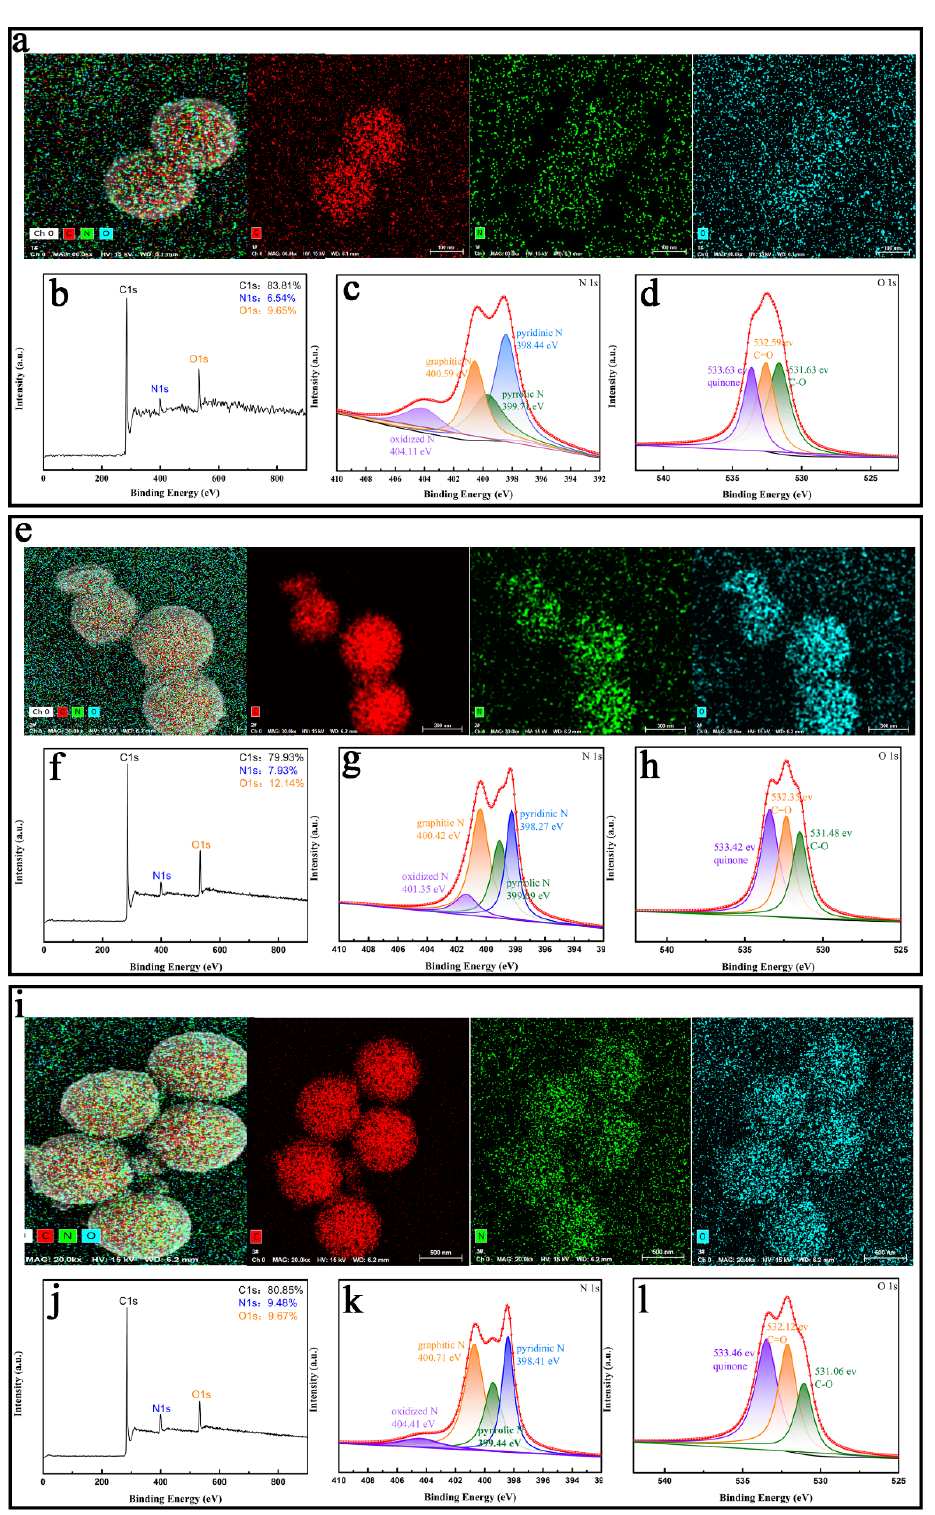
Figure 7. The ( a ) EDS element mapping analysis, ( b ) XPS survey spectrum, ( c ) high-resolution XPS spectra of N 1 s and ( d ) high-resolution XPS spectra of O 1 s for NMMCNs-2, the ( e ) EDS element mapping analysis, ( f ) XPS survey spectrum, ( g ) high-resolution XPS spectra of N 1 s and ( h ) high- resolution XPS spectra of O 1 s for NMMCNs-7 and the ( i ) EDS element mapping analysis, ( j ) XPS survey spectrum, ( k ) high-resolution XPS spectra of N 1 s and ( l ) high-resolution XPS spectra of O 1 s the